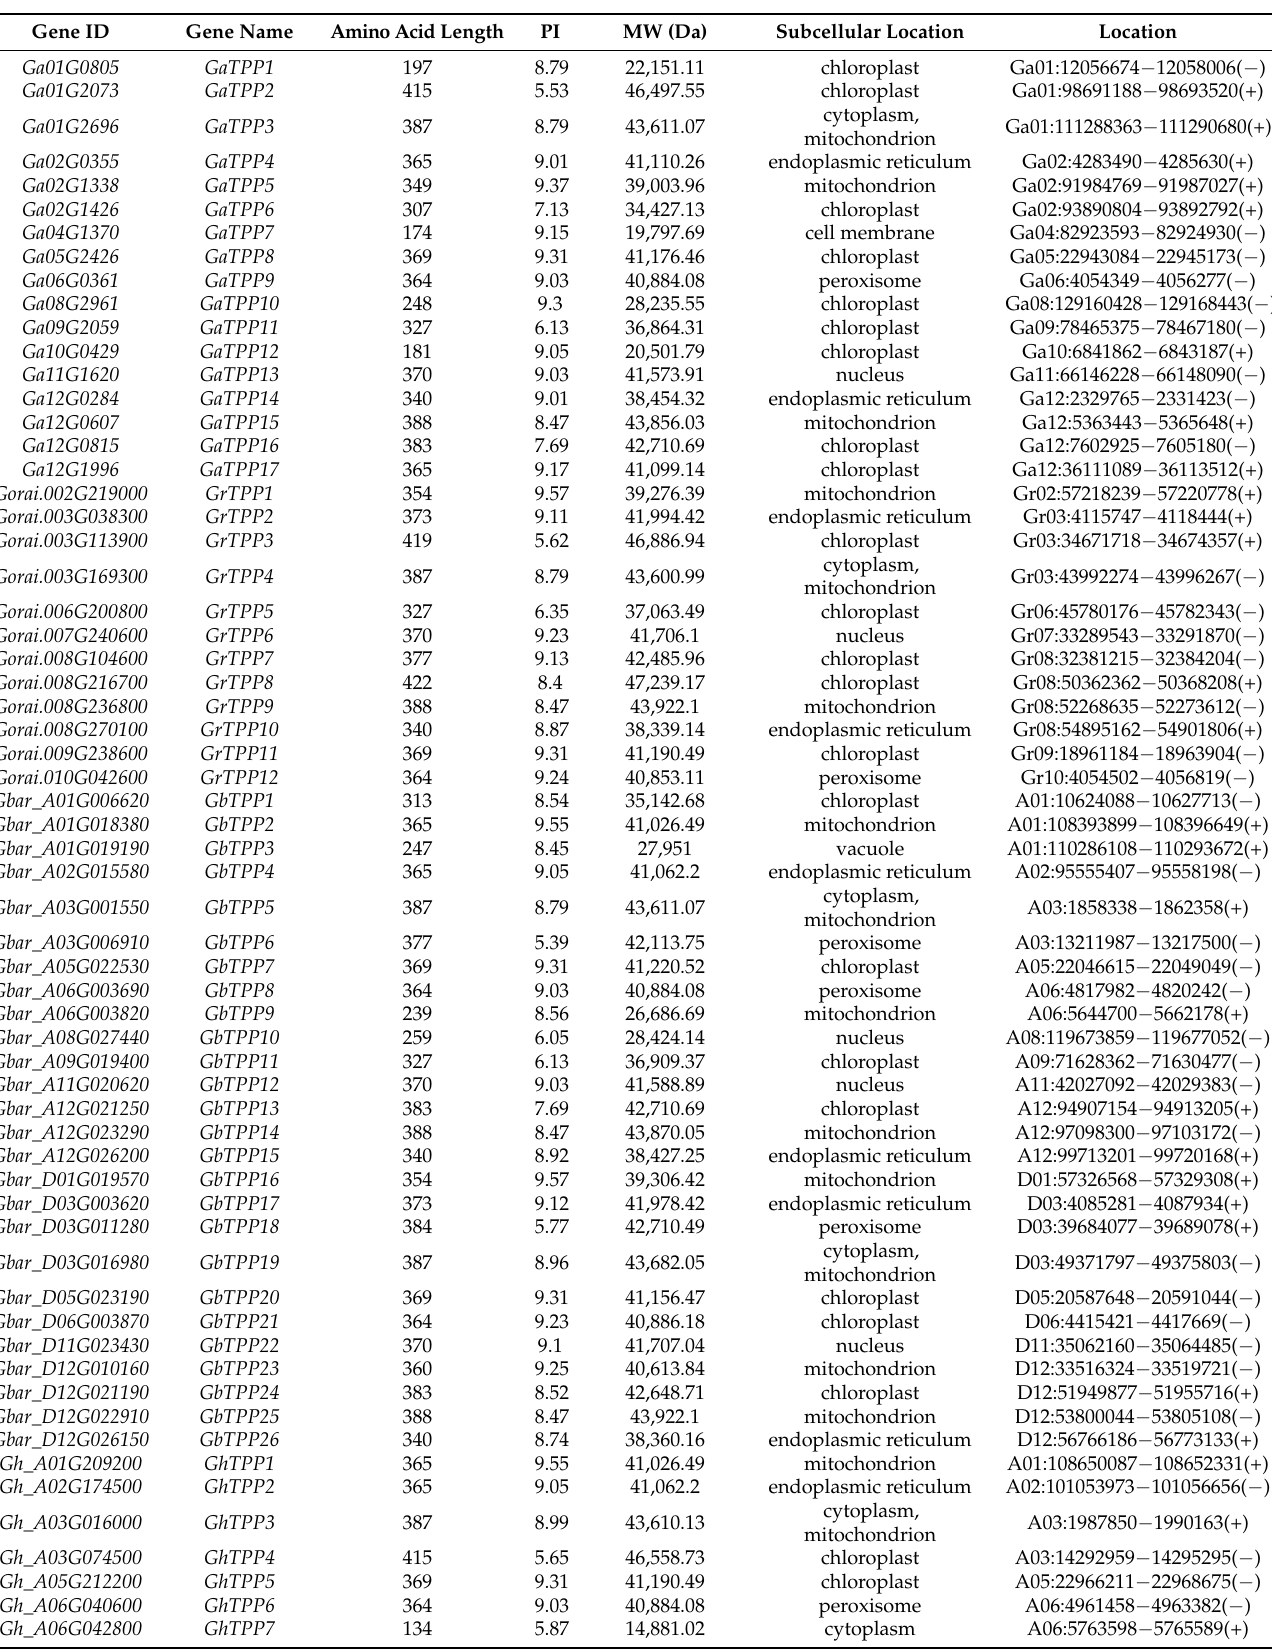
Table 1. Basic information of TPP family genes in